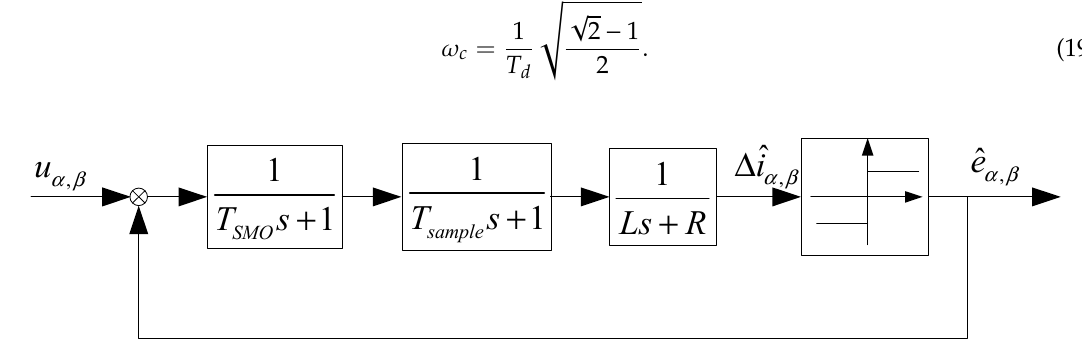
Figure 4. Equivalent block diagram of the conventional SMO.